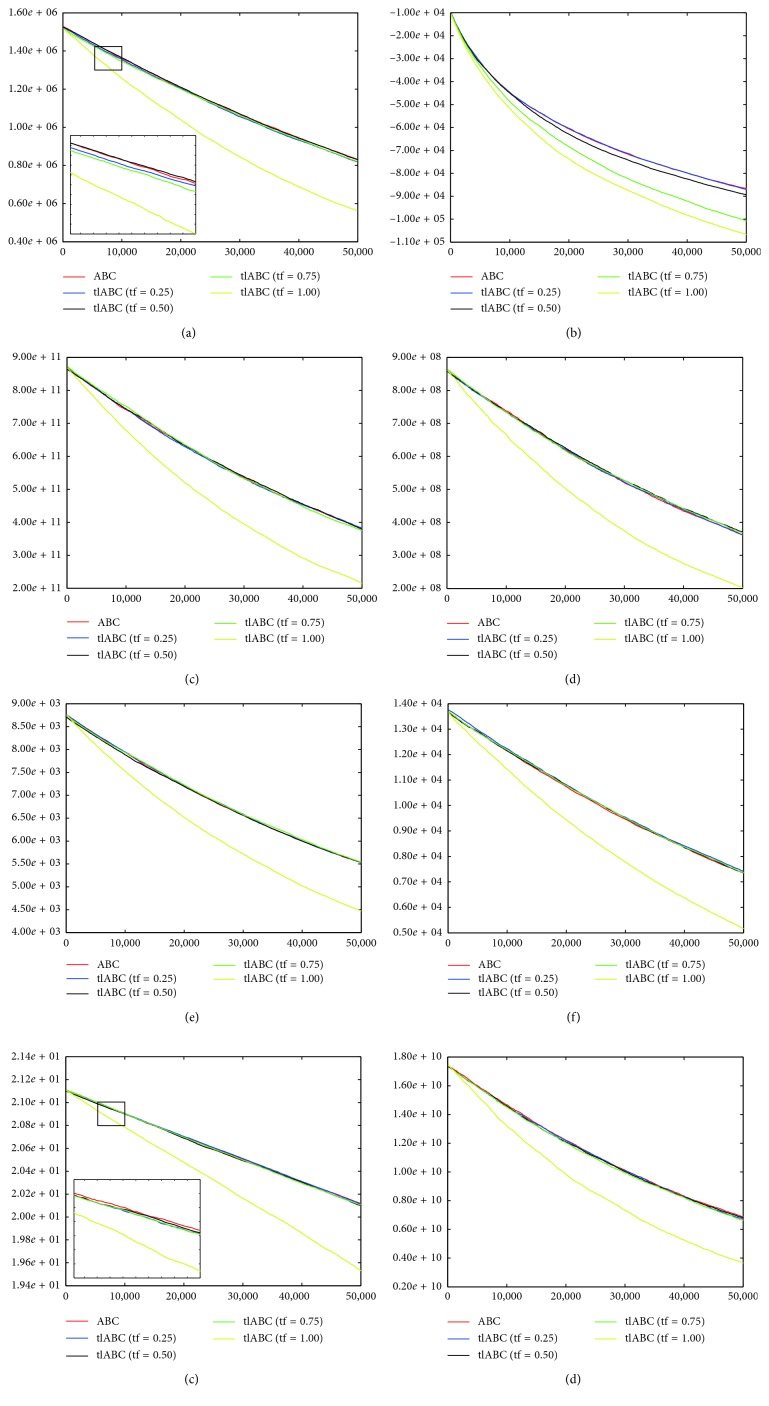
Convergence graphics of 500-dimensional f1 (a), f3 (b), f4 (c), f5 (d), f6 (e), f7 (f), f8 (g), and f9 (h) functions for ABC and tlABC algorithms.